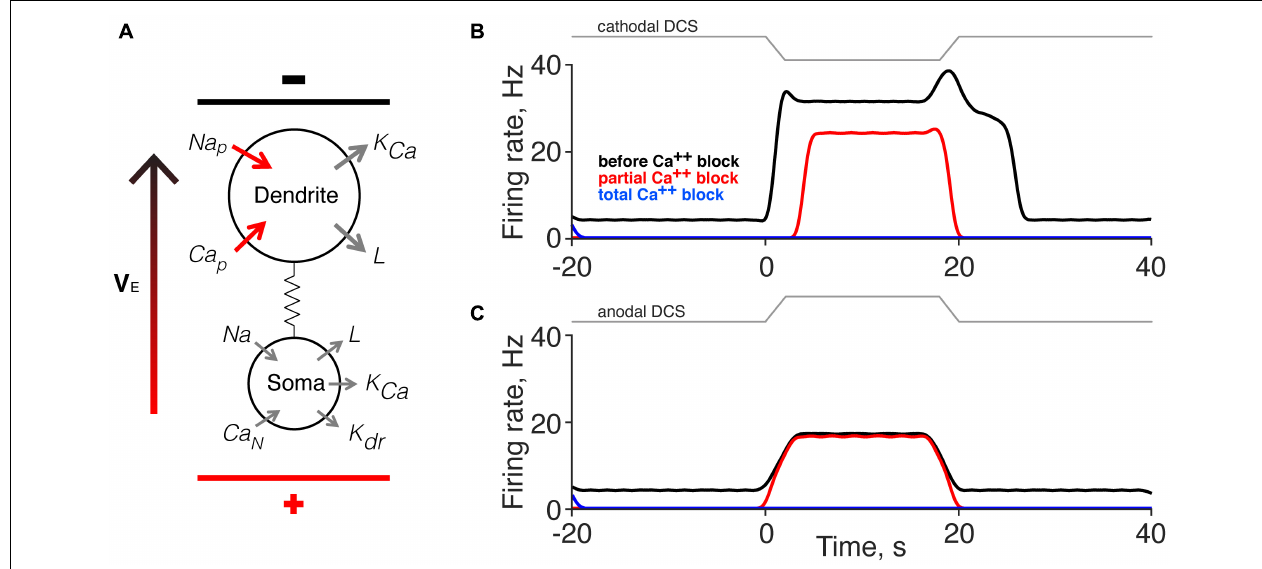
FIGURE 6 | Computer simulation of the effects of direct current stimulation (DCS) on the direct and persistent responses. (A) Schematic of the motoneuron model (Booth et al., 1997). Applied DCS was modeled as an external electrical field (V E ), which induces a current between soma and dendrite. The configuration in the model illustration corresponds to cathodal-tsDCS (c-tsDCS) in the experiment. Ca p , Calcium, persistent; Ca n , Calcium, N-like; K Ca , Potassium, Ca 2 + dependent; K dr , Potassium, delayed rectified; L, maximal leakage conductance; Na, maximal Sodium conductance; Na p , Sodium, persistent. (B,C) Computer simulation for response change produced by c-tsDCS (B) and anodal-tsDCS (a-tsDCS) (C) . The responses during c-tsDCS were stronger than that during a-tsDCS. Only c-tsDCS induced a persistent firing of motor units. The responses during c-tsDCS showed calcium channel-dependent; there was a reduction in the direct response and elimination of the persistent response. In contrast, the responses during a-tsDCS were not calcium channel dependent. Total calcium channel blockade eliminated all